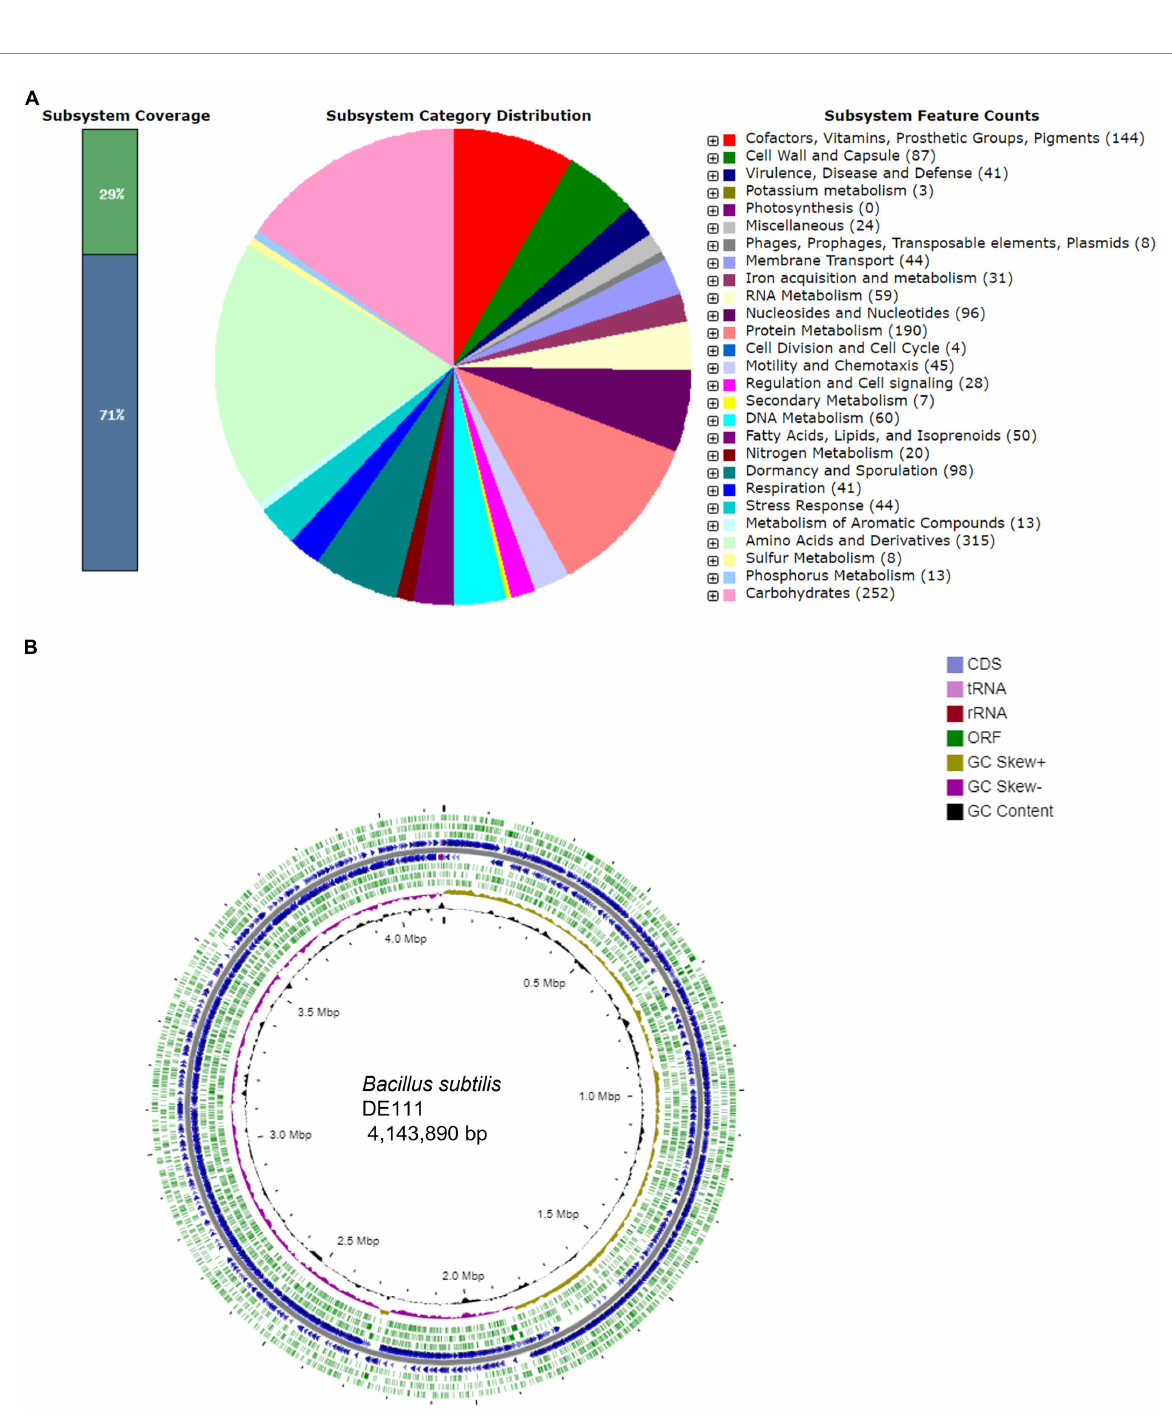
FIGURE 1 (A) Subsystem distribution of Bacillus subtilis DE111 ® strain (based on RAST annotation server). In subsystem coverage, 29% is indicated in subsystem and 71% is not in the subsystem. The most genome ontology subsystems are amino acids and derivatives which are accounted for 315. (B) Genome information of Bacillus subtilis DE111 ® . Circles display (from the inside): Circle 1 represents GC content (black). Circle 2 represents GC skew (GC skew +: gold, GC skew − : purple). Circle 3 represents ORF’s (ORF’s − strand: green). Circle 4 represents predicted CDS (blue) and circle 5 represents ORF’s (ORF’s + strand: green). Gene GC skew (G − C/G + C), 5. rRNA (red) and tRNA